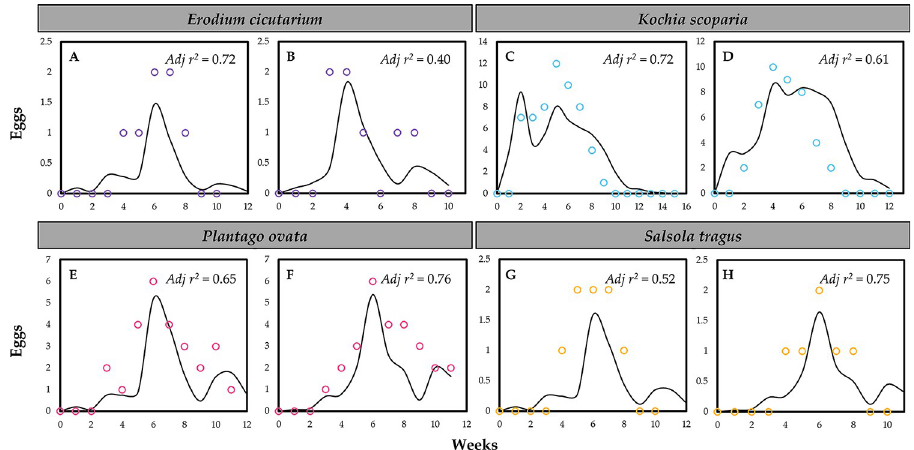
Fig 5. Model validation for oviposition of beet leafhoppers on four non-agricultural host plant species, (A and B) Erodium cicutarium , (C and D) Kochia scoparia , (E and F) Plantago ovata , and (G and H) Salsola tragus , under fluctuating temperature conditions (see S1 Table). Open dots and solid lines represent observed oviposition and the oviposition model outputs,